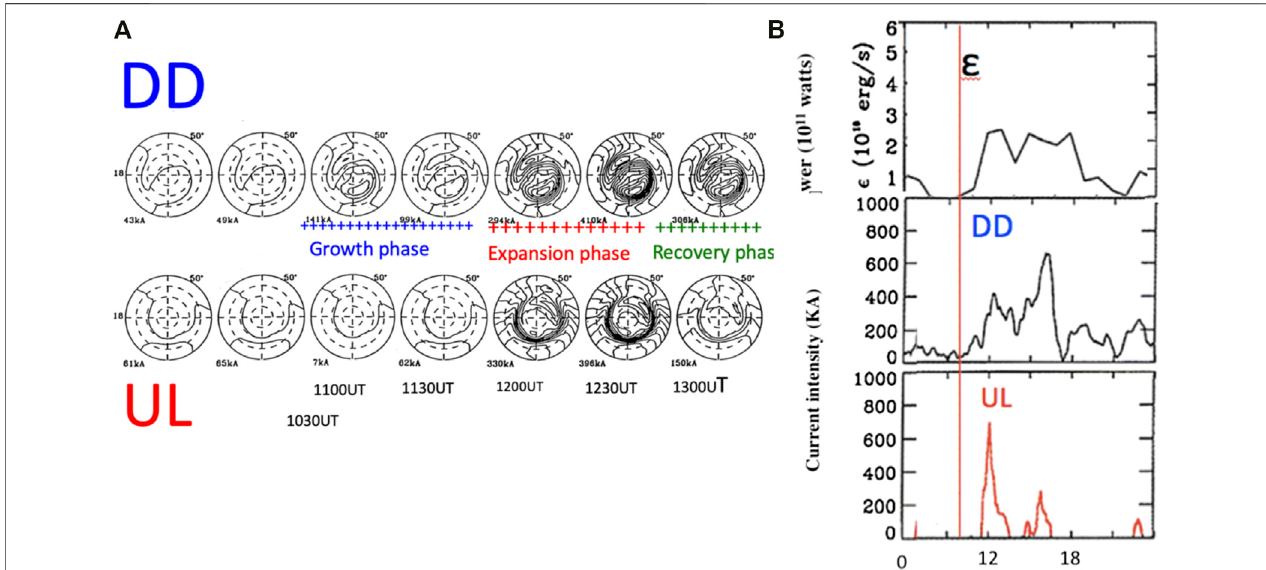
FIGURE 18 | (A) Changes of the directly driven (DD) current and the unloading (UL) current during a typical substorm; the three phases are shown. (B) The relationship between the power P ( (cid:1) ε /8 π ), the intensity of the DD current, and the UL current during the same substorm as Figure 12A . The red line is a guide to show the relative time relationship between the three quantities. Both are for the same